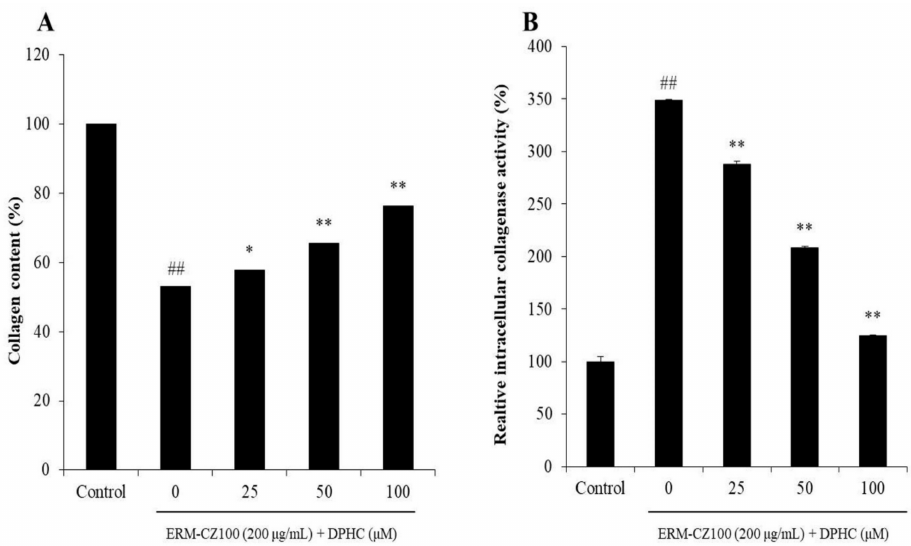
Figure 3. DPHC protected collagen synthesis and inhibited intracellular collagenase activity in ERM- CZ100-stimulated HDF cells. ( A ) The e ff ect of DPHC on collagen synthesis in ERM-CZ100-stimulated HDF cells, and ( B ) the e ff ect of DPHC on relative collagenase activity in ERM-CZ100-stimulated HDF cells. The data were expressed as the mean ± SE ( n = 3). * p < 0.05, ** p < 0.01 as compared to the ERM- CZ100-treated group, and ## p < 0.01 as compared to the control